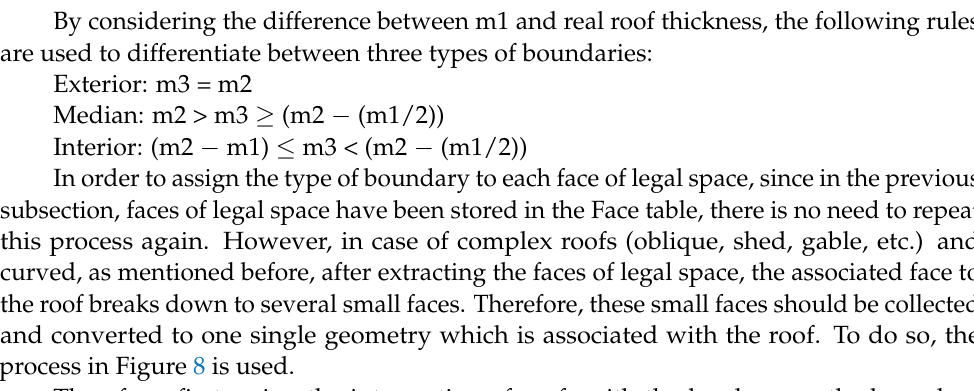
Figure 7. Difference between the real roof thickness and